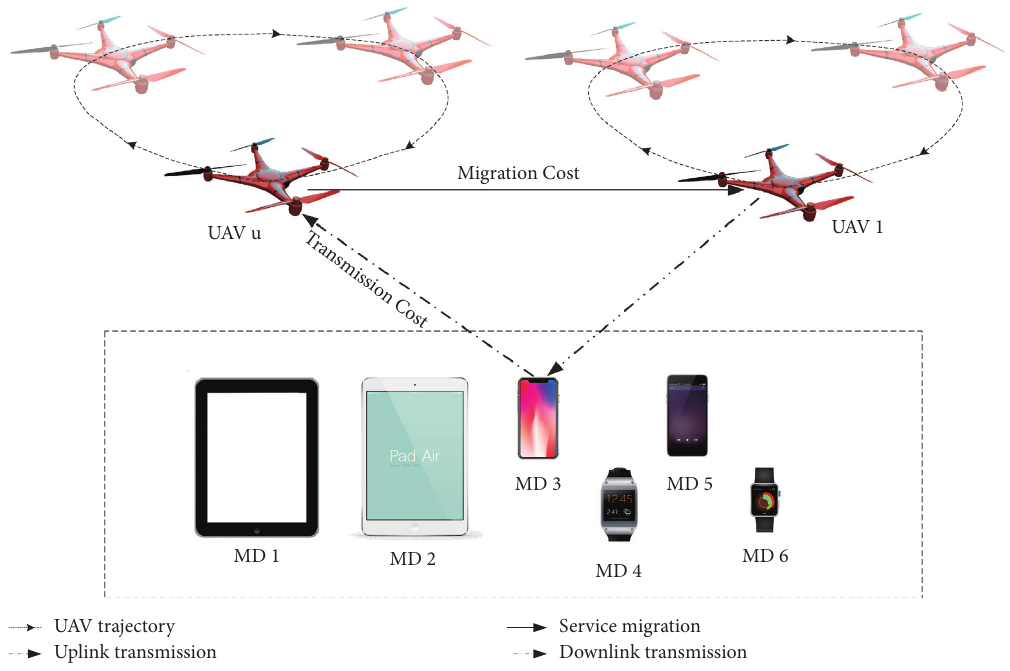
Figure 2: The dynamic process of task migration from UAV u to UAV